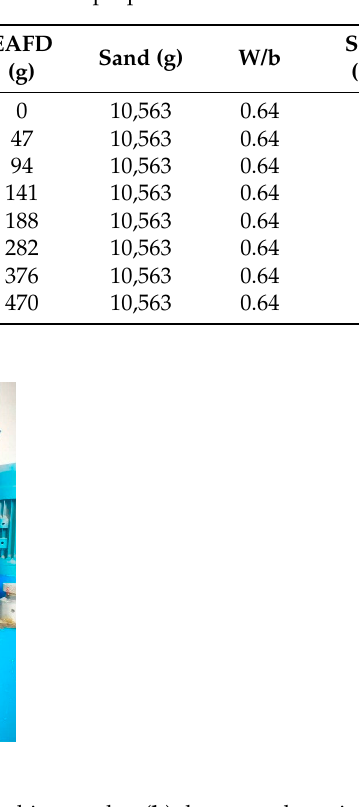
Table 2. Mix proportions of all mortars and their properties.